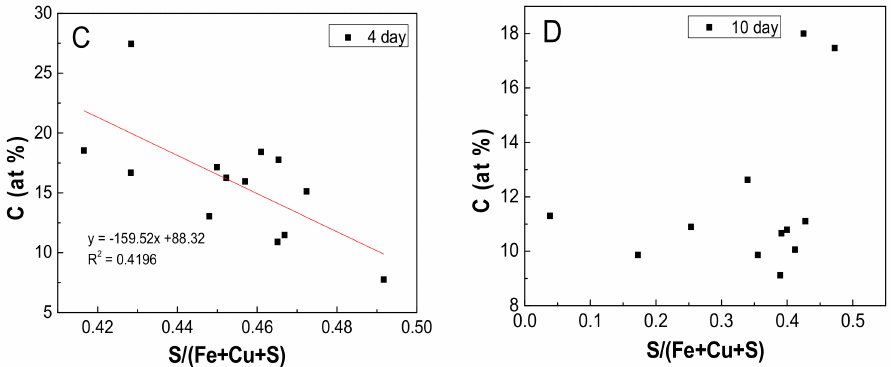
Figure 8. The relationship between the content of C and Fe/(Cu+Fe+S) at ( A ) day 4 and ( B ) day 10 and the content of C with S/(Cu+Fe+S) at ( C ) day 4 and ( D ) day 10.